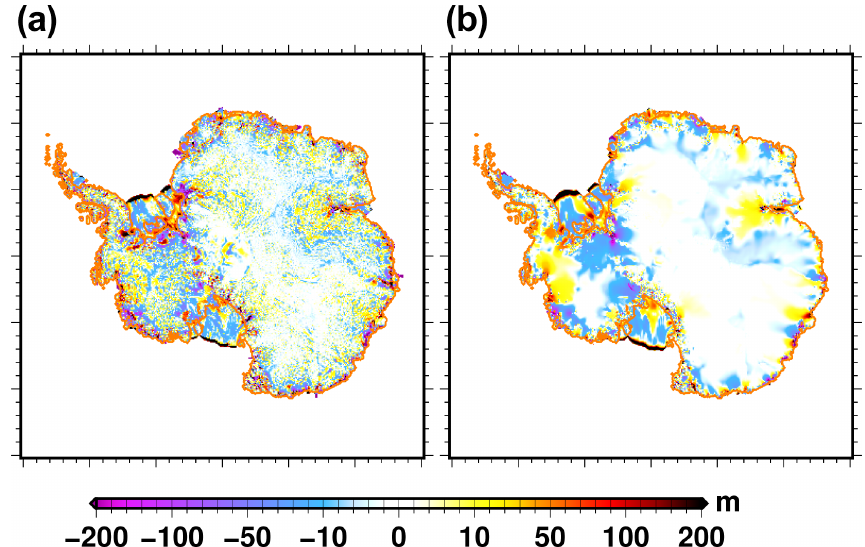
Figure 2. Ice thickness difference: (a) end of the historical experiment hist with respect to observations (Fretwell et al., 2013), (b) end of the control experiment ctrl_proj with respect to the end of the historical experiment hist . The orange line shows the present-day grounded line. The Pearson correlation coefficient between (a) and (b) is